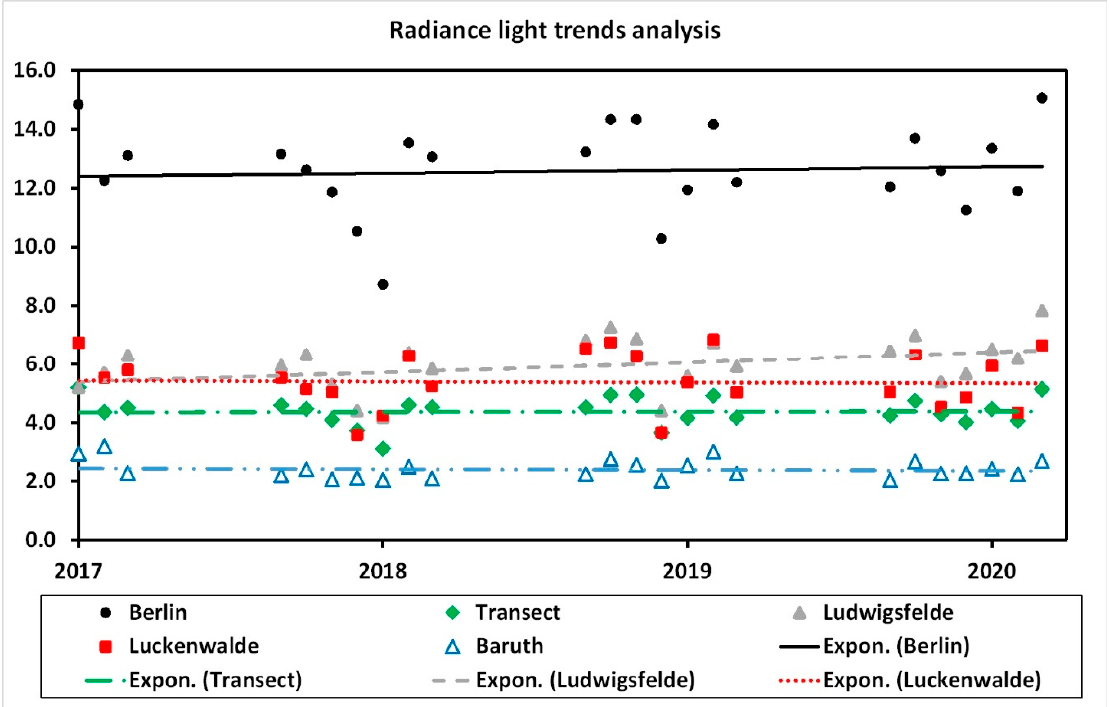
Figure A7. VIIRS DNB time series obtained from radiance light trend web tool [40] for the study area (green diamonds), Berlin (black solid circles), the town of Baruth (blue open triangles), the town of Luckenwalde (red solid squares) and the town of Ludwigsfelde (grey solid triangles). Exponential fits are shown in the same colors as the areas investigated.